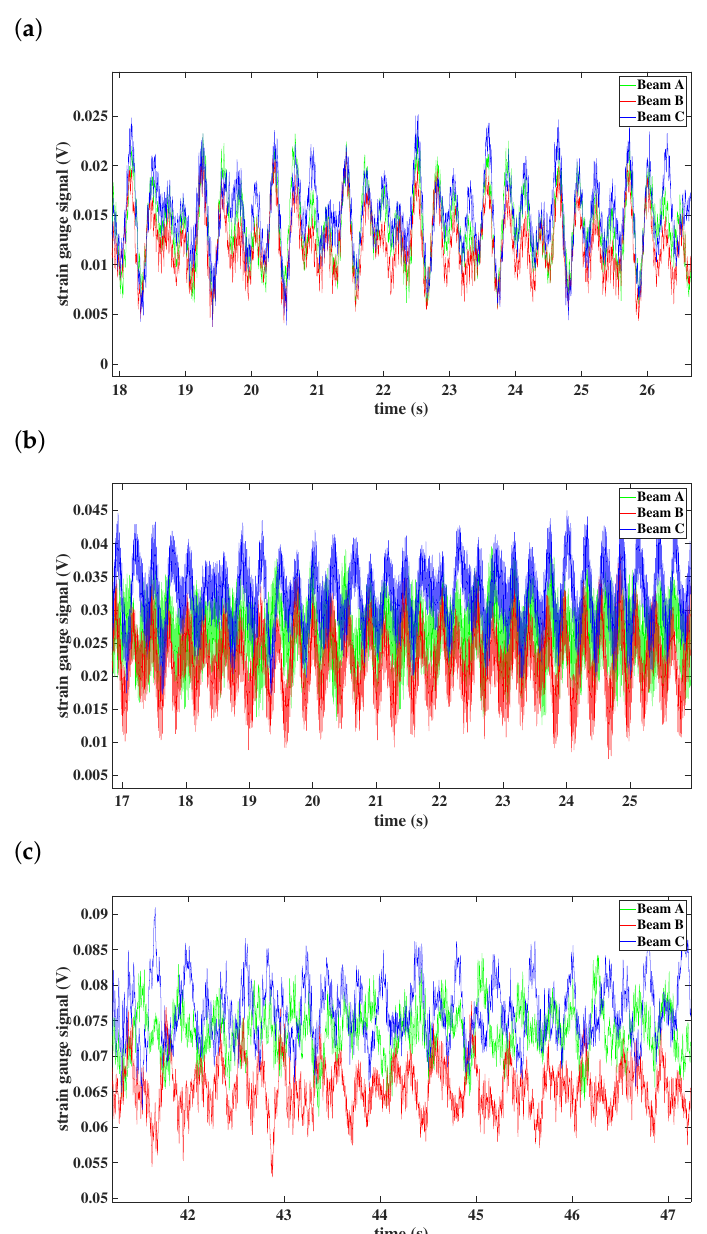
Figure 18. Time histories of individual beams: ( a ) preset angle 45 ◦ and angular speed 50 rpm, ( b ) preset angle 45 ◦ and angular speed 100 rpm, ( c ) preset angle 45 ◦ and angular speed 150